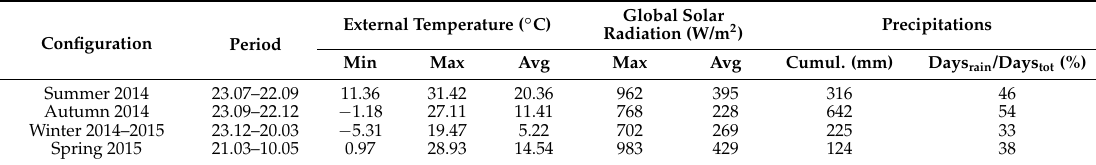
Table 1. Main outdoor environmental parameters (external temperatures: minimum (Min), maximum (Max), average (Avg); global solar radiation: maximum (Max), average (Avg); and precipitation: cumulated (Cumul.), Days rain /Days tot ) typical of the monitored period.